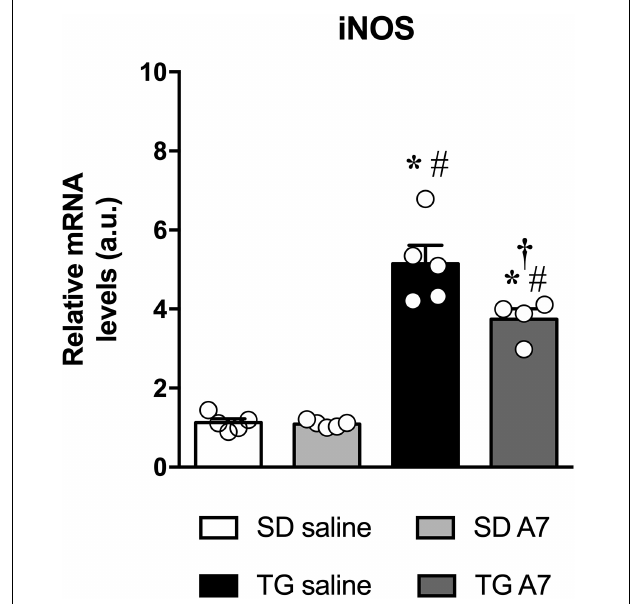
FIGURE 4 | Expression of mRNA for iNOS in the hypothalamus in SD and hypertensive rats treated with Ang-(1-7) ICV. Results are expressed as mean ± SEM. n = 4 or 5. * p < 0.05 vs. SD saline; # p < 0.05 vs. SD A7; † p < 0.05 vs. TG saline (One-way ANOVA followed by Newman-Keuls post hoc test).